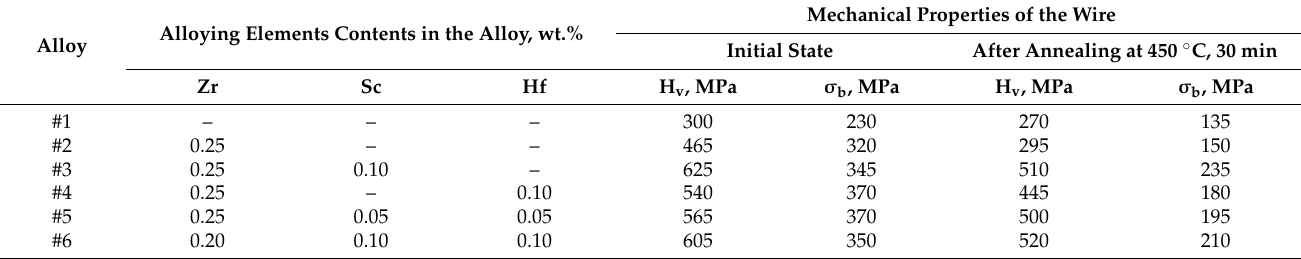
Table 1. The composition and mechanical properties of conductor Al alloys. Alloying Elements Contents in the Alloy, Alloy